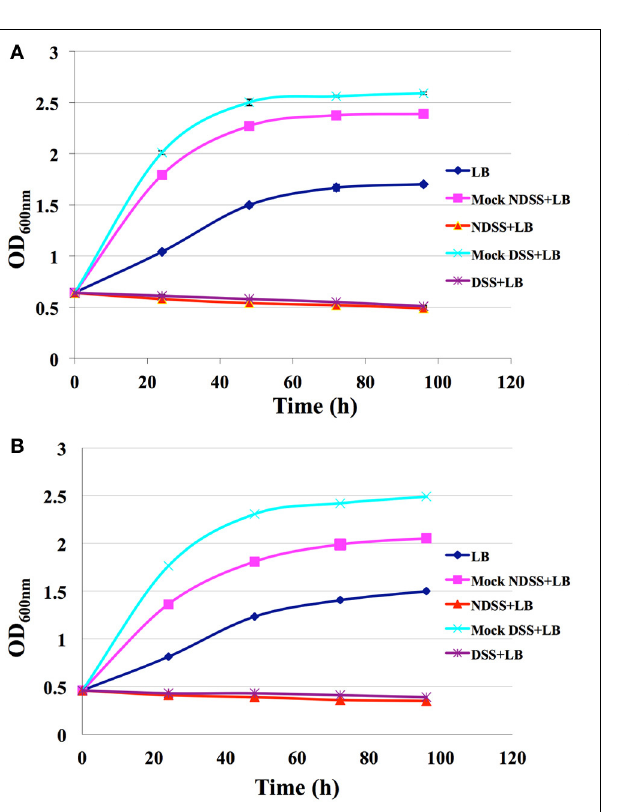
FIGURE 1 | Growth of C. necator in LB, mock media and pre-treated saccharified lignocellulosic slurry at original 1-fold concentration (A); or at a 2-fold dilution (B).